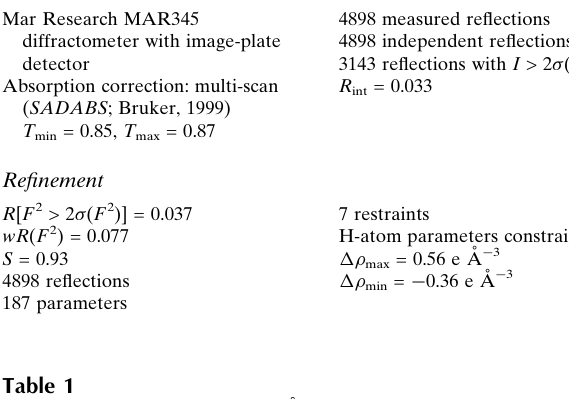
Selected geometric parameters (A˚ , (cid:1)